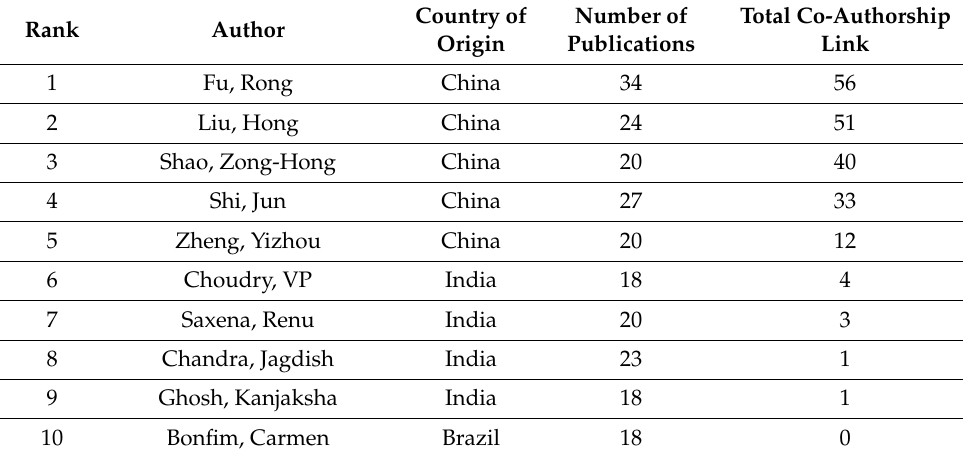
Table 1. Ranking of the top ten authors in BRICS countries.